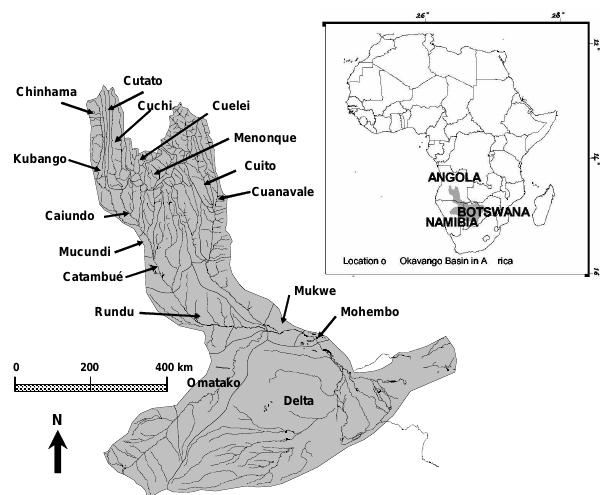
Fig. 1. Okavango River showing the modeled sub-basins. Most of Okavango River showing the modeled sub-basins. Most of the gauged 685 the gauged sub-basins are labeled with arrows and the insert shows sub-basins are labeled with arrows and the insert shows the location 686 the location within within Africa. 687